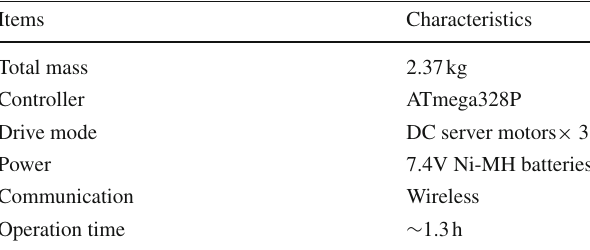
Fig. 2 The mechanical configuration of the proposed biomimetic robotic fish Table 1 Technical specification of the proposed biomimetic robotic